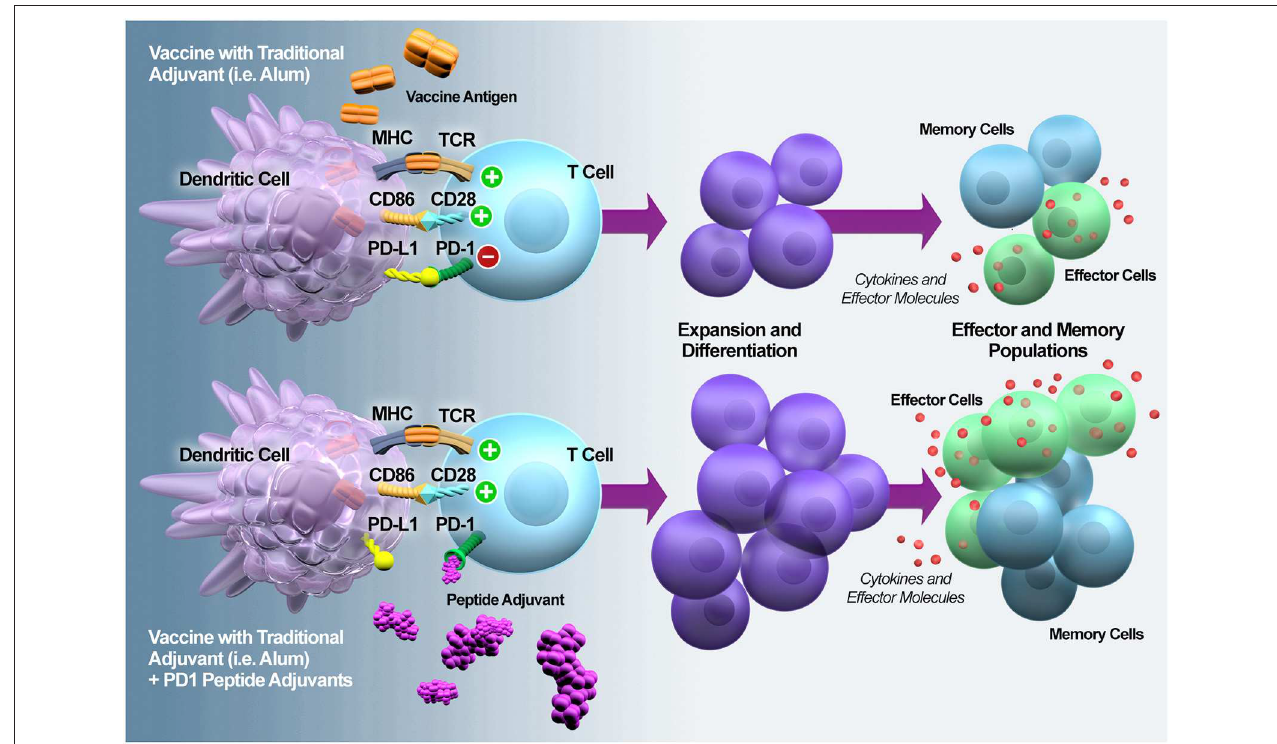
FIGURE 8 | PD1 antagonization potentiates T cell expansion and differentiation into effector and memory T cells. PD1 is rapidly upregulated upon naïve T cell activation and it plays a regulatory role during naïve-to-effector T cell differentiation (37). In the context of vaccination, MacLeod et al. (38) demonstrated that the magnitude of PD1 expression on the activated T cells is adjuvant-dependent. Thus, adding a PD1 peptide adjuvant during the early phase of vaccine-induced T cell activation should modulate expansion and differentiation, resulting in enhanced numbers and functionality of effector and memory T